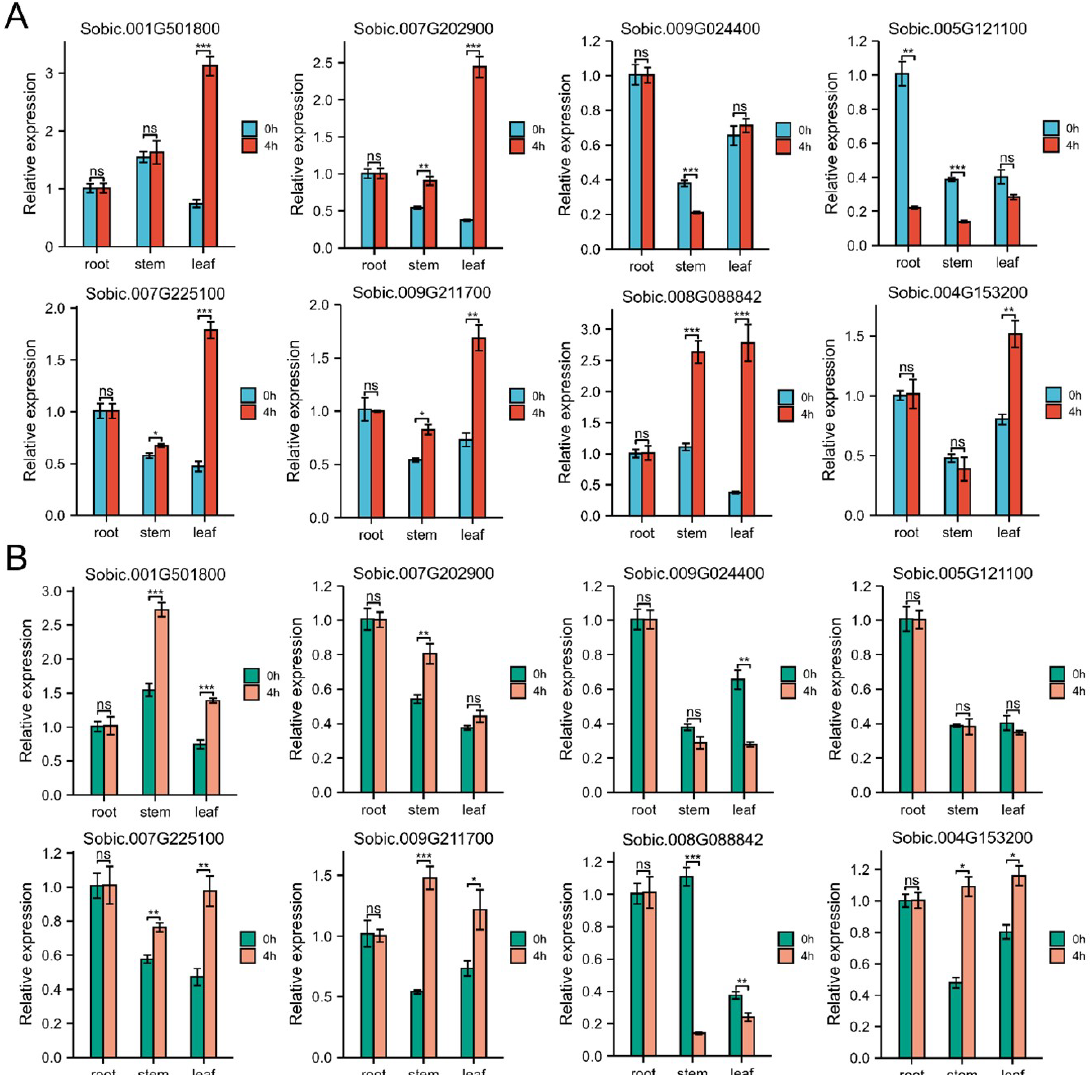
Figure 7. Expression of 8 SbC2H2-ZFP genes under cold ( A ) and PEG ( B ) stresses at the seedling stage. Error bars are obtained from three biological replicates, and standard error is selected as the value of the bar. Asterisks display significant expression differences of genes after treatment (* p < 0.05, ** p < 0.01, *** p < 0.001; t -test).